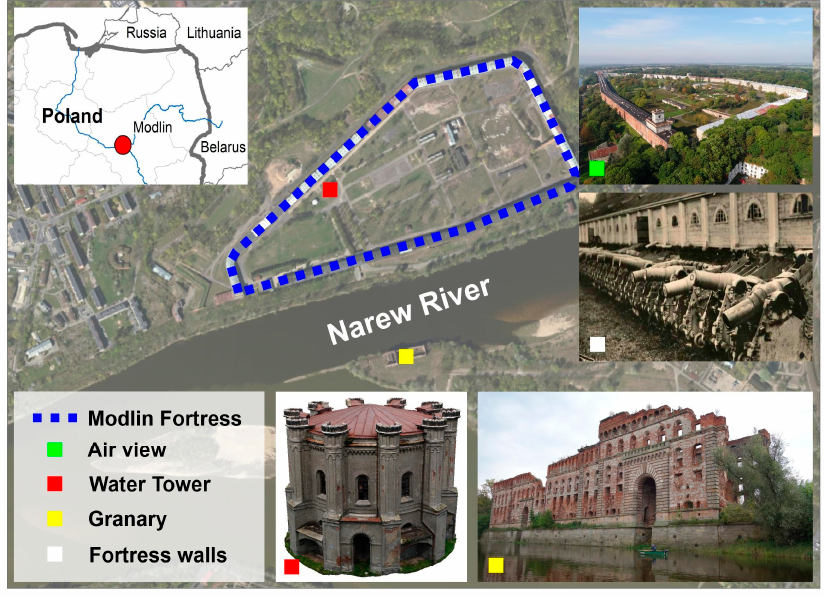
Figure 3. Study area.